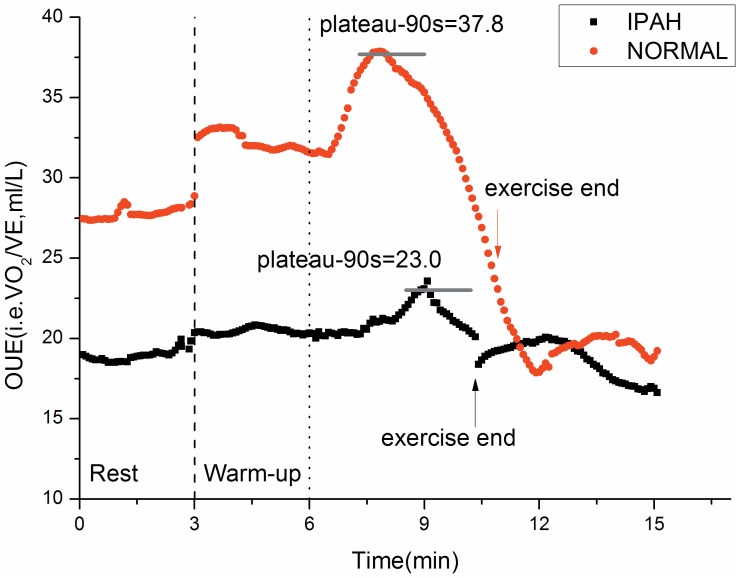
Difference of OUEP and OUE between a typical IPAH patient and a control subject.The kinetics of changes in oxygen uptake efficiency (OUE) for the same tests and subjects as depicted in Figure 1. OUE typically increase during exercise from rest to plateau in normal subjects and then decrease gradually until exercise end. It then decreases further in the immediate recovery period and begin stabilizing after about 2 minutes. In IPAH patients, OUE changes in a similar way as the controls, but is always lower than the controls in the transition from rest to exercise end.